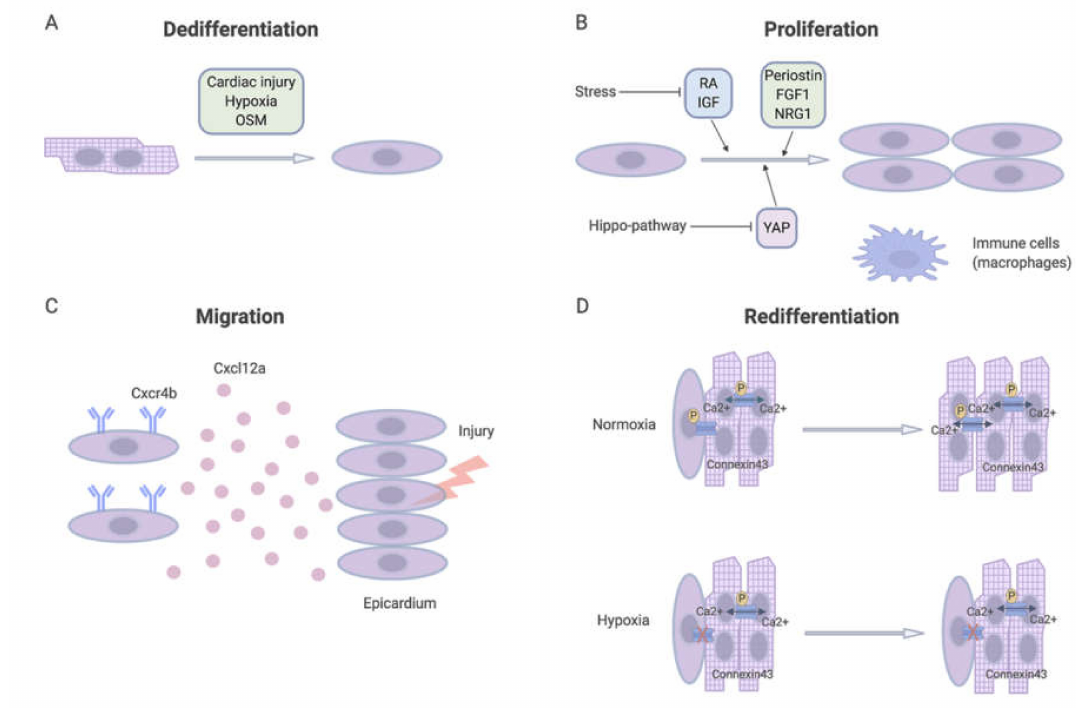
Figure 3. Four processes model of cardiac regeneration. A . Dedi ff erentiation. cardiac regeneration begins with dedi ff erentiation of preexisting di ff erentiated cardiomyocytes after injury. It can be induced by hypoxia as well as OSM. B . Proliferation. After dedi ff erentiation, cardiomyocyte can start proliferation, which can be greatly enhanced by growth factors and cytokines as well as Hippo-YAP signaling pathway. C . Migration. Cardiac injury induce chemokine Cxcl12a expression and cardiomyocytes in the epicardium start to express its receptor Cxcr4b. Damage area enriched Cxcl12a expression stimulates the migration of cardiomyocytes toward the damaged area. D . Redi ff erentiation. When the newly formed cardiomyocytes arrive at the damaged area, they need to re-di ff erentiate and become electrically coupled with the preexisting cardiomyocytes. OSM: Oncostain M; RA: Retinoic acid; IGF: Insulin-like growth factor; FGF1: fibroblast growth factor one; NRG1: Neuregulin